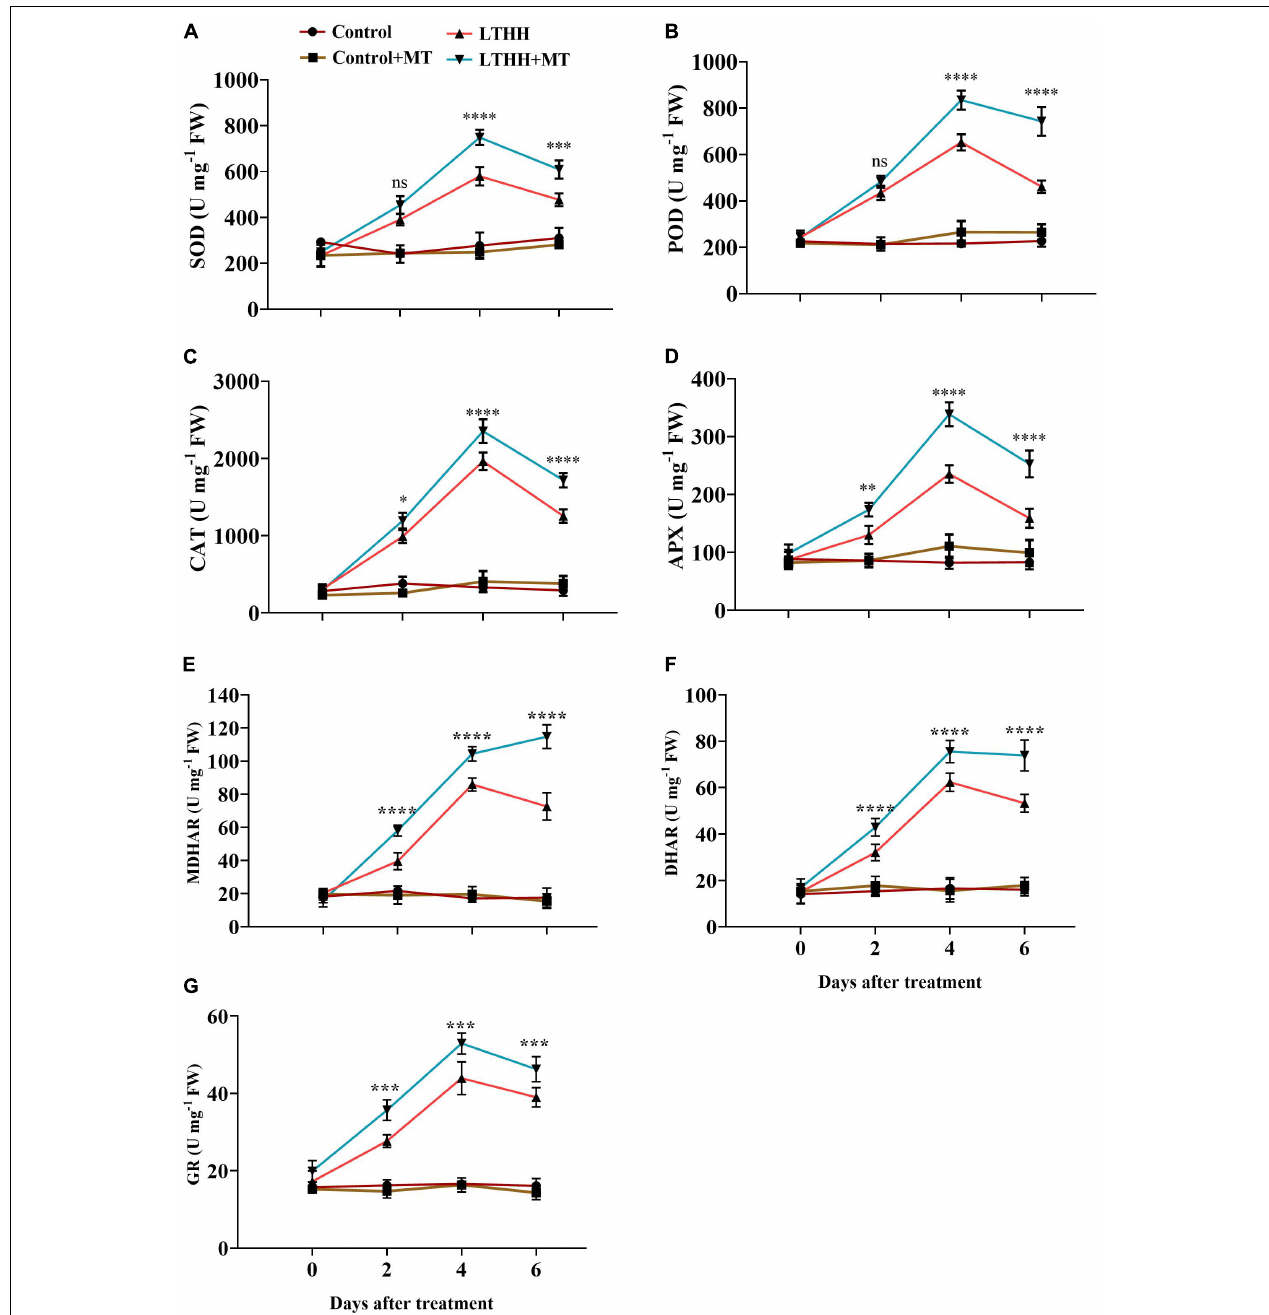
FIGURE 3 | Effect of exogenous melatonin on superoxide dismutase (A) , peroxidase (B) , catalase (C) , ascorbate peroxidase (D) monodehydroascorbate reductase (E) , dehydroascorbate reductase (F) , and glutathione reductase (G) , activities of cucumber seedling under low-temperature and high-humidity stress. Control (25/18 ◦ C); Control + MT (200 µ M melatonin, 25/18 ◦ C); LTHH (15/10 ◦ C, 95%); LTHH + MT (200 µ M melatonin, 15/10 ◦ C, 95%). Results were presented as means ± SD ( n = 3), significance values were presented as: * P < 0.05; ** P < 0.01; *** P < 0.001; **** P < 0.0001; while non-significant (ns) ( P >